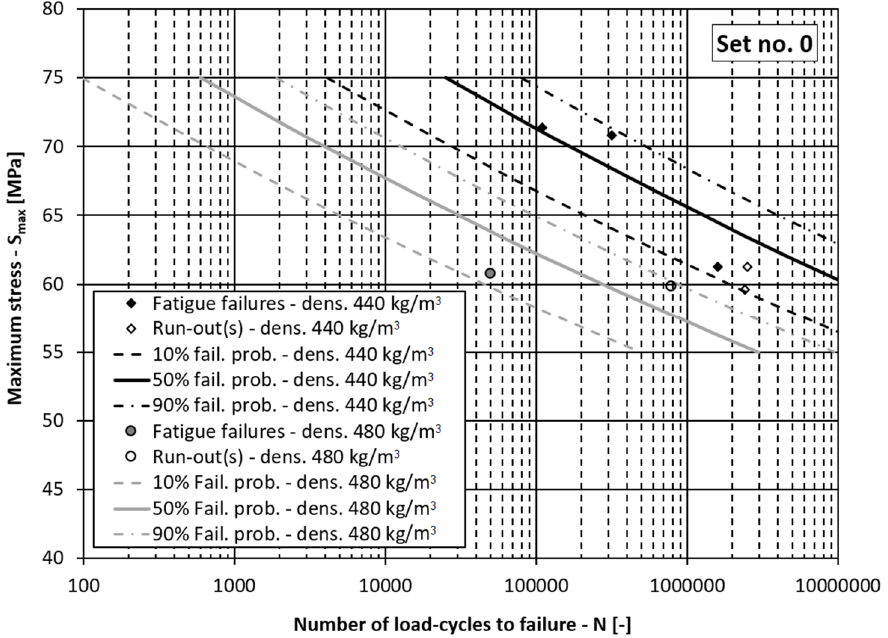
Figure 4: Fatigue-life curves with scatter for the processing lot 2 ( D = 0), densities ρ = 440 and 485 kg/m 3 and the tangential loading direction ( O = 0): Figure 5: Fatigue-life curves with scatter for the processing lot 1 ( D = 1), densities ρ = 400 and 440 kg/m 3 and the tangential loading direction ( O = 0); Figure 6: Fatigue-life curves with scatter for the processing lot 1 ( D = 1), density ρ = 400 kg/m 3 and the radial loading direction ( O = 1).